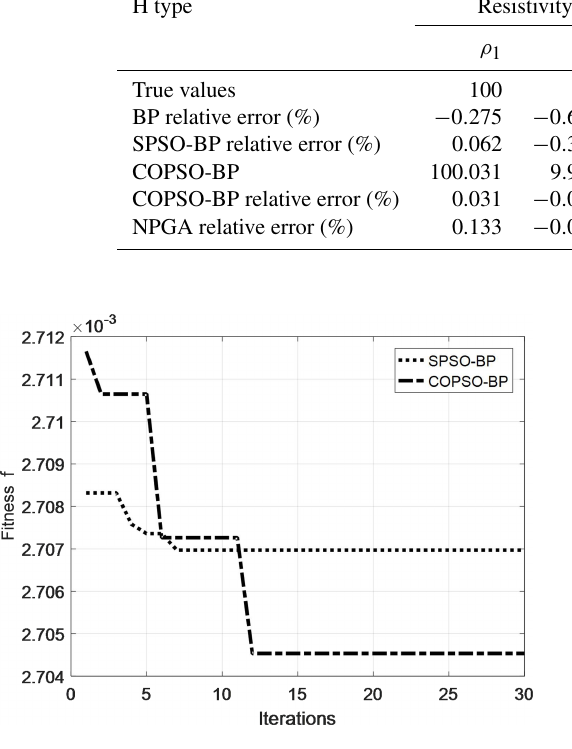
Figure 9. Fitness curves of SPSO-BP and COPSO-BP.